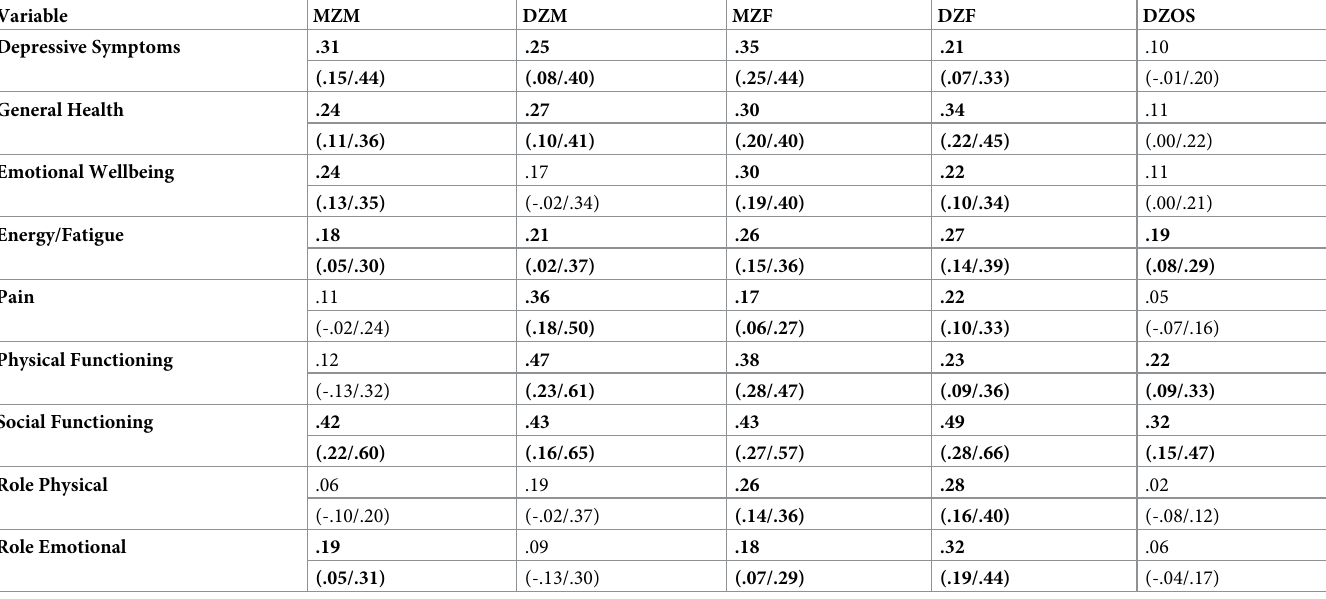
Table 3. Cross-twin within-trait correlations for depressive symptoms and SF-36 scales in same and opposite sex twin pairs (with 95% CIs).